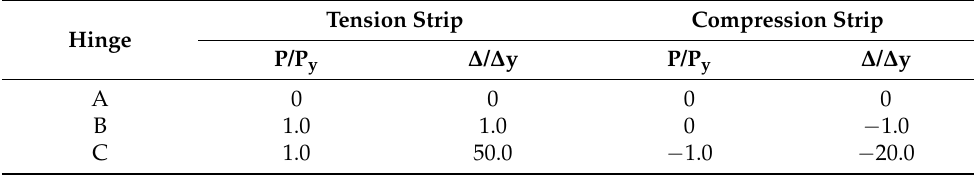
Figure 7. Bi-linear model for the strips.